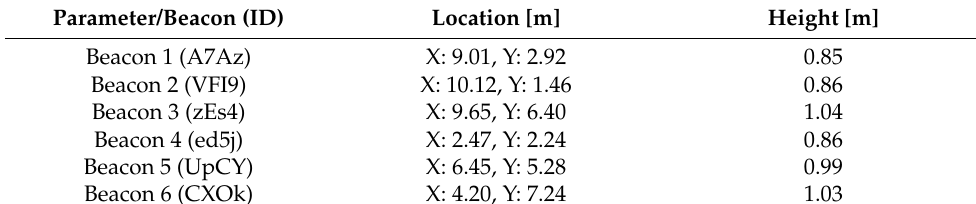
Table 4. Location and height of beacons used in the office/laboratory setting.